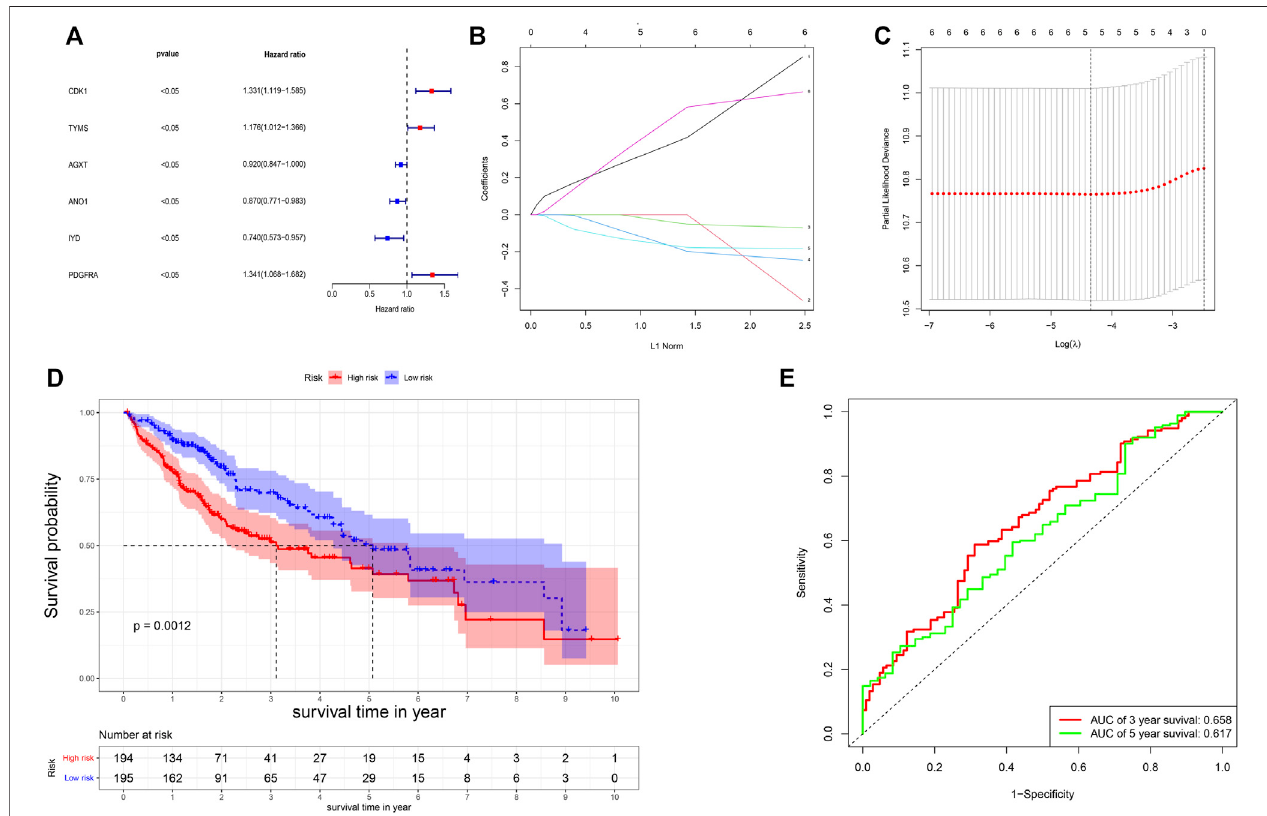
FIGURE 2 | Construction of the risk score. (A) Results of the univariate analysis; (B,C) Lasso regression analysis of the genes from univariate analysis. (D) Survival probability based on the high and low-risk group. (E) ROC curve for the 3- and 5-year overall survival.